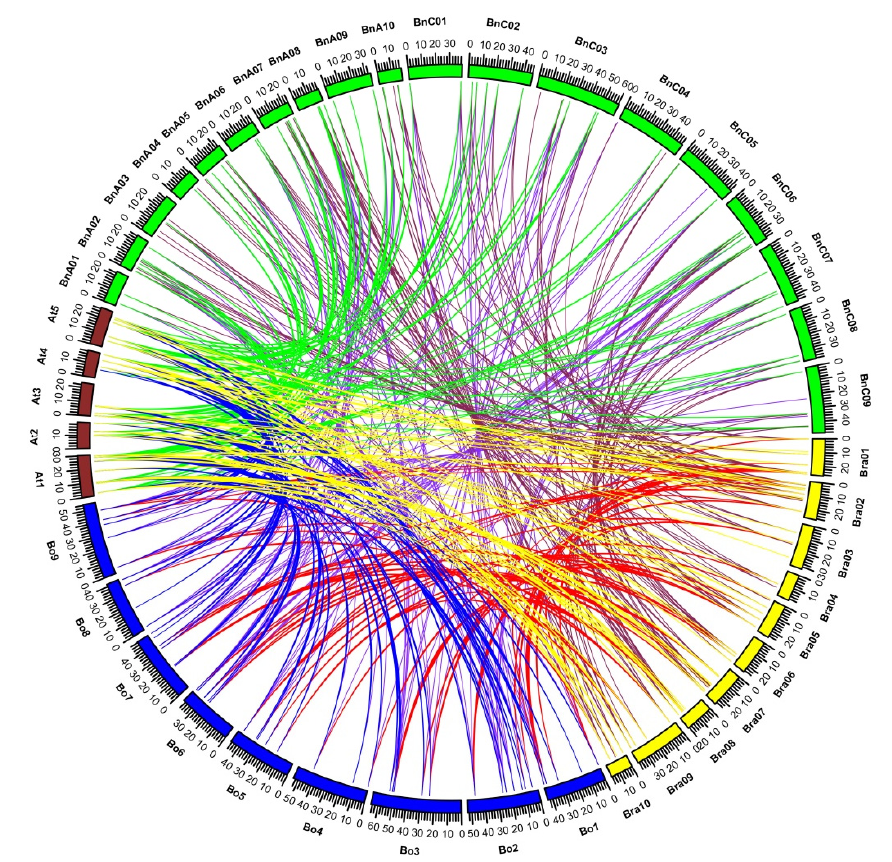
Figure 7. Brassica rapa (Bra01–Bra10), B. oleracea (C01–C09), B. napus (Bna01–Bna10 and Bnc01–Bnc09), and Arabidopsis thaliana (At1–At5) chromosomal maps were constructed according to orthologous gene pair positions. The maps revealed highly conserved synteny. The orange, blue, and red curves link the BBX genes on A. thaliana chromosomes 1, 2, 3, 4, and 5 with their orthologous genes in B. rapa , B. oleracea , and B. napus , respectively.